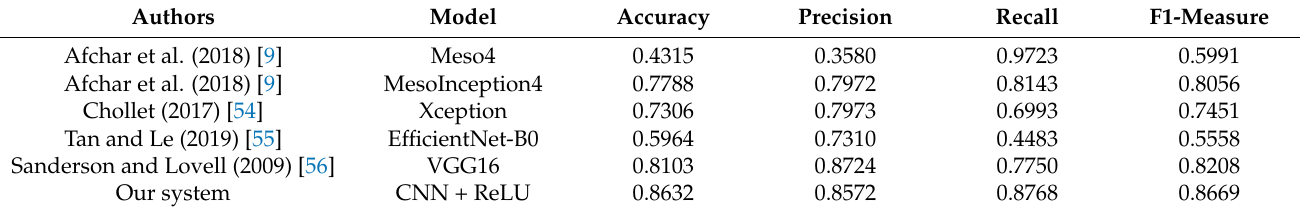
Table 8. Performance evaluation in contrast to other cutting-edge techniques in DeepFake detec- tion.